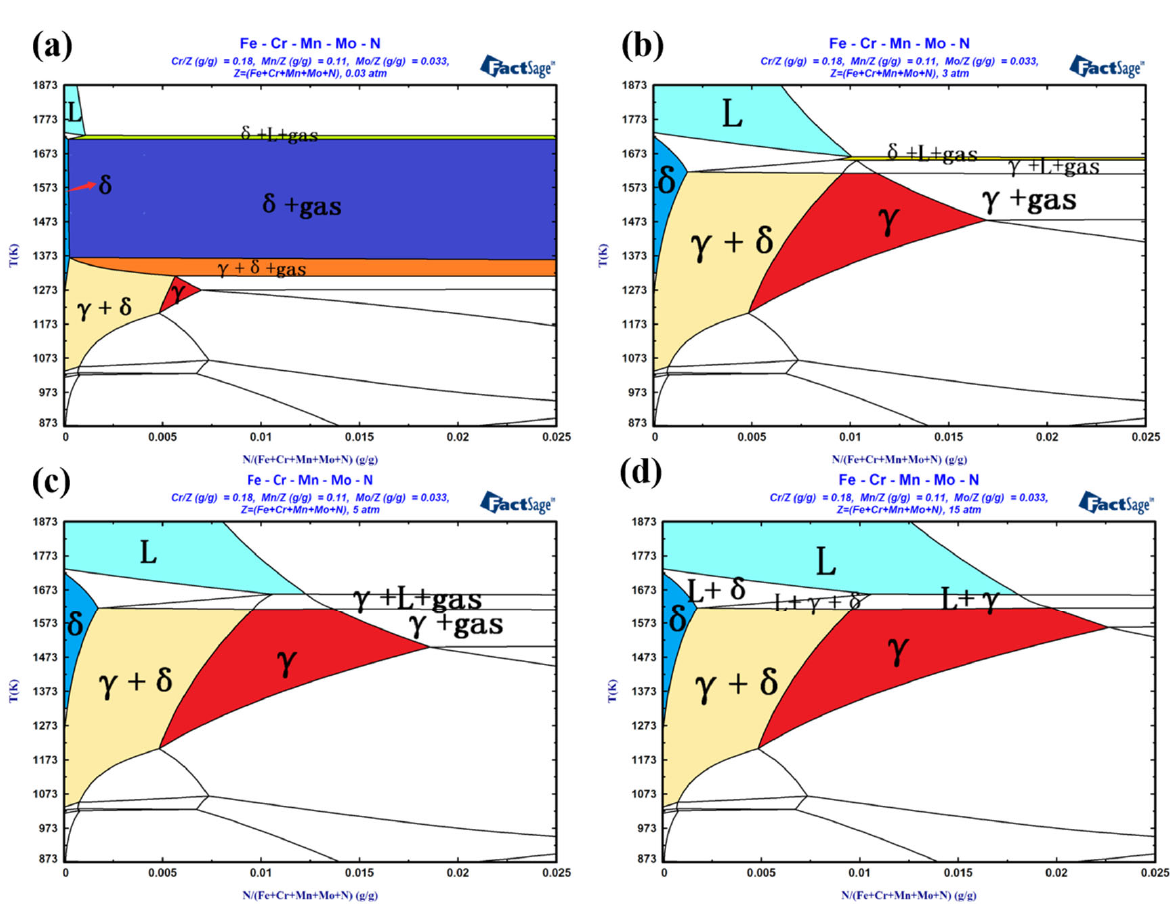
Figure 6. Fe-N binary phase diagram under different melting pressure: ( a ) 0.003 MPa; ( b ) 0.3 MPa; ( c ) 0.5 MPa; ( d ) 1.5 Mpa.